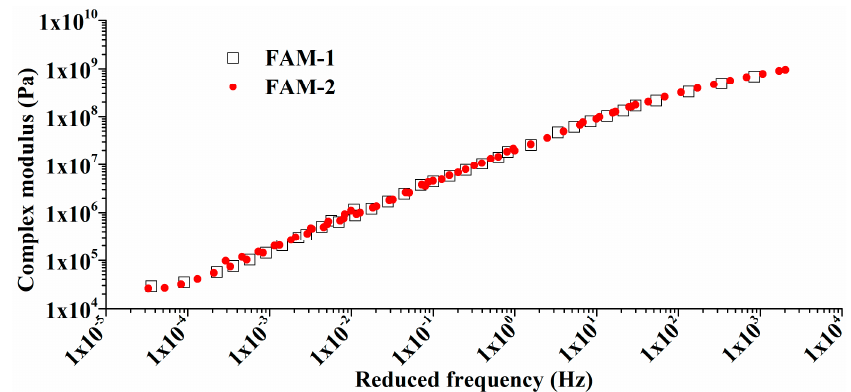
| G * | for two di ff erent tests at 30 ◦